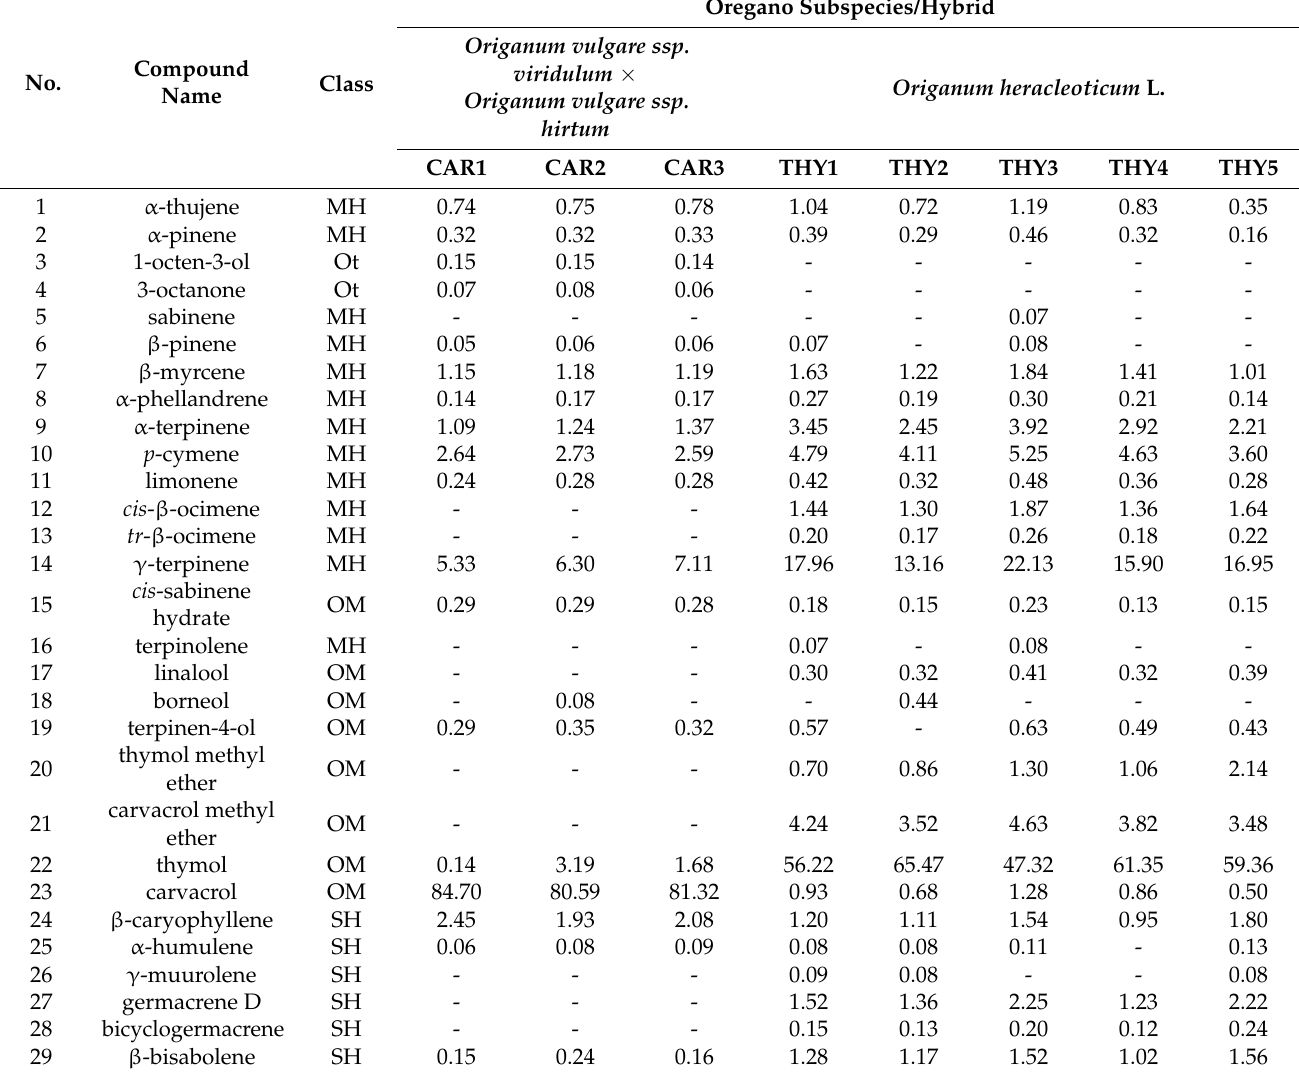
Table 1. Chemical compositions of the EOs of the hybrid Origanum vulgare ssp. viridulum × Origanum vulgare ssp. hirtum (CAR1, CAR2, CAR3) and of the subspecies Origanum heracleoticum L. (THY1, THY2, THY3, THY4, THY5). Data are expressed as the % content of individual